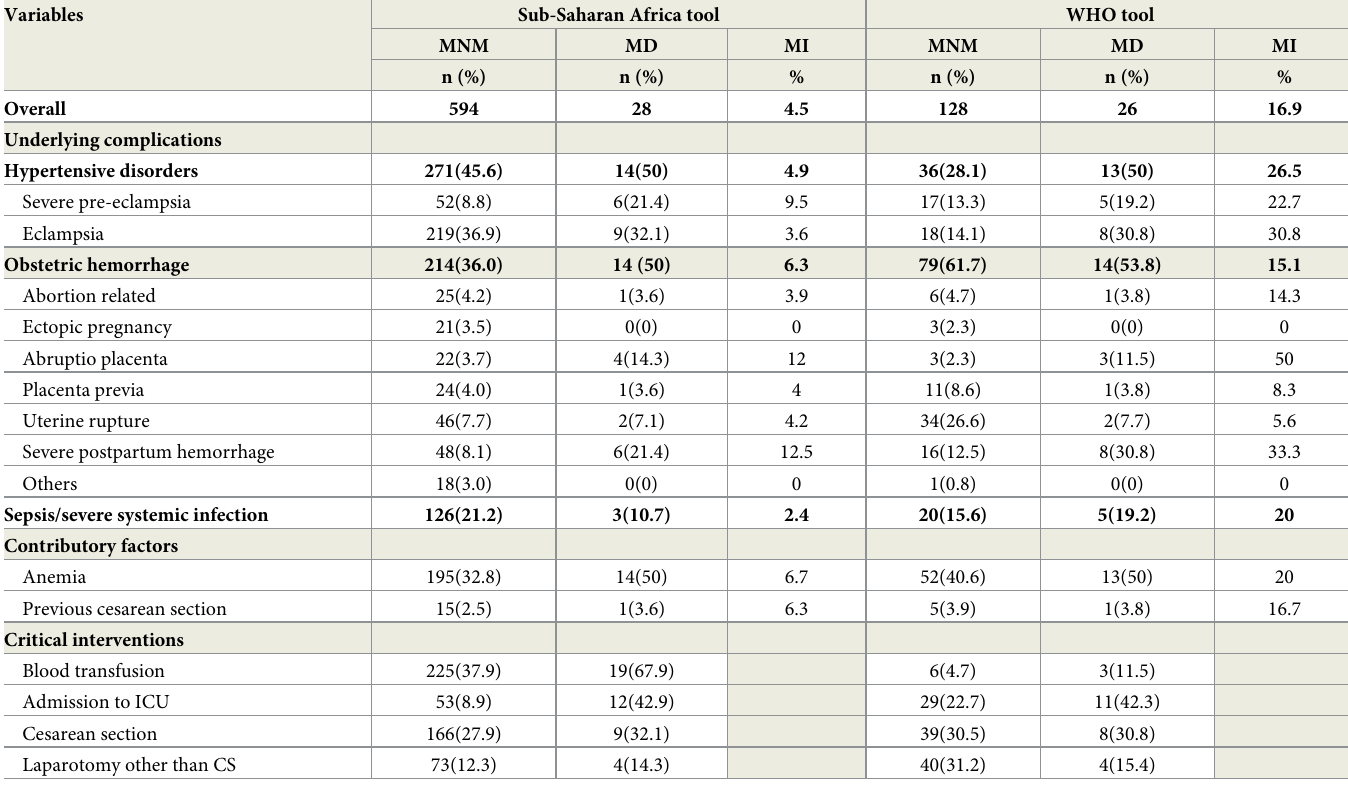
Table 5. Underlying causes of life-threatening conditions and severe maternal outcomes in eastern